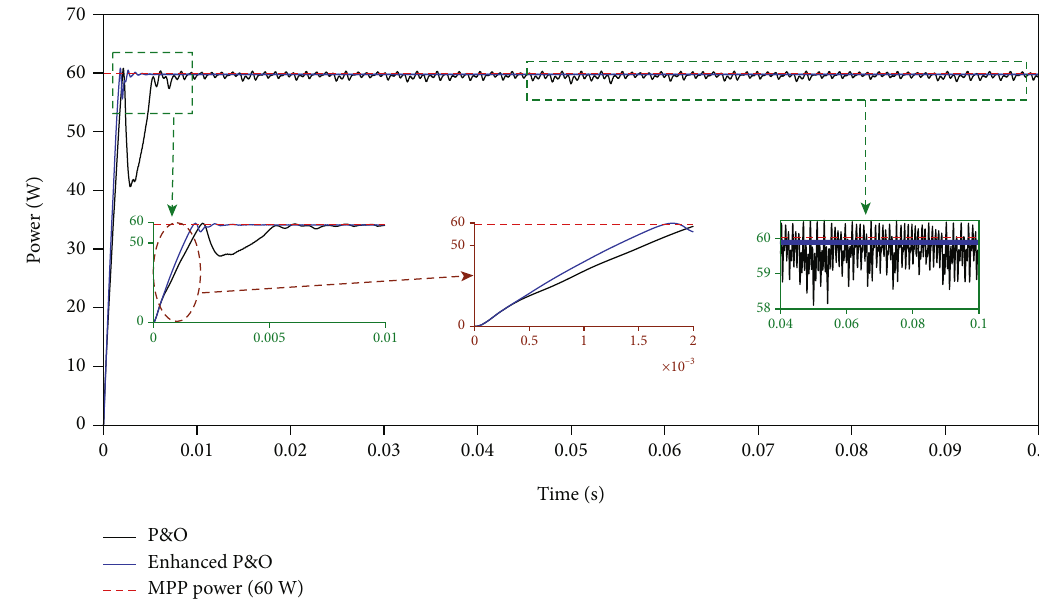
Figure 11: Tracking of MPP power with P&O enhanced P&O method under Test 1. Table 6: Performance comparison of the enhanced P&O MPPT with the conventional